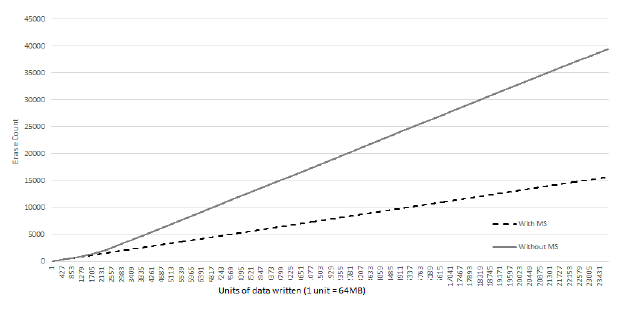
Figure 5.1. Erase Count MLC